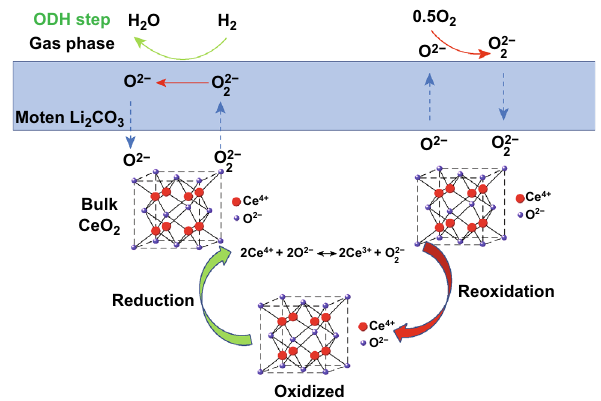
Fig. 6 Illustration of the mechanism of the peroxide (O 22− ) ion con‑ duction for ceria–carbonate heterostructure